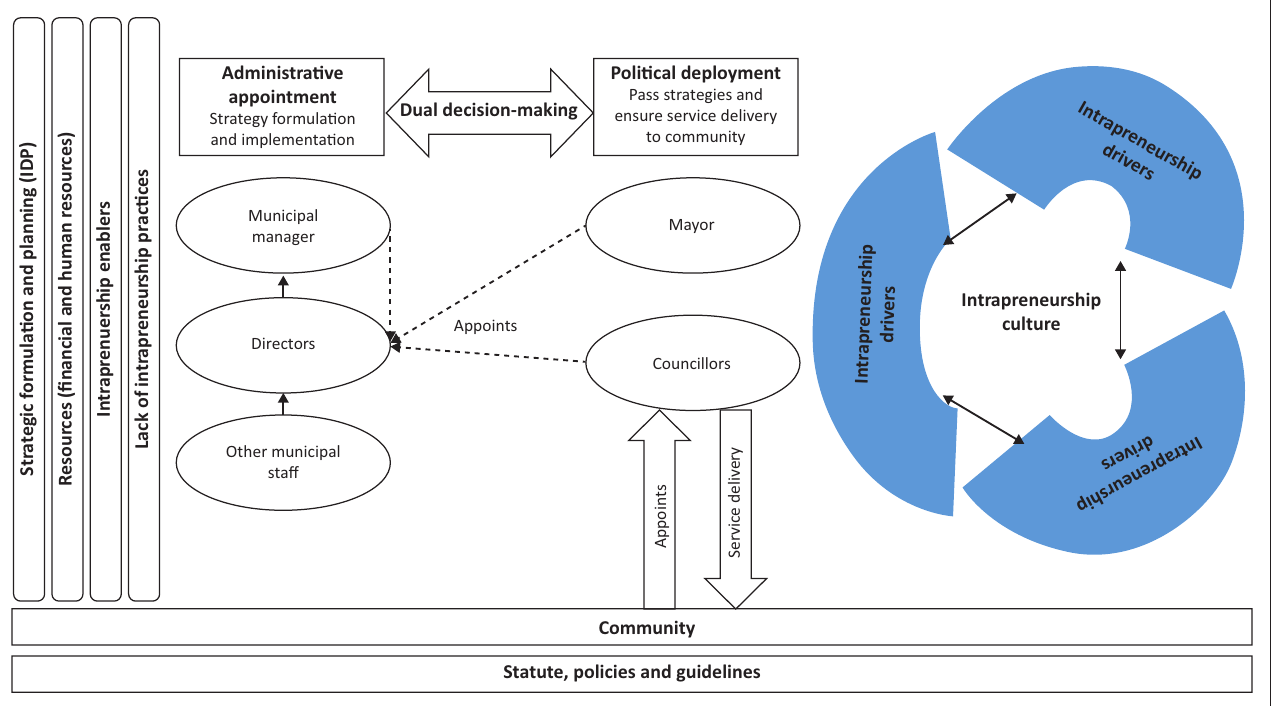
FIG URE 1: Framework for the integration of intrapreneurship drivers in municipalities to improve service delivery.